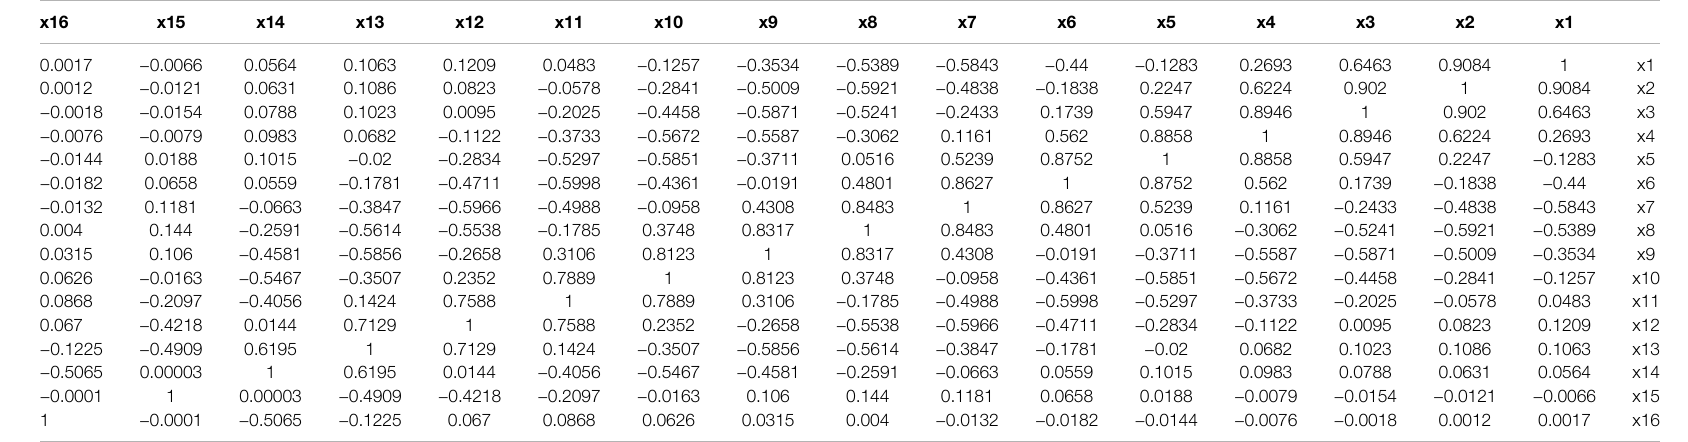
TABLE 1 | Pearson product-moment correlation coef fi cient of the two output sequences before decorrelation